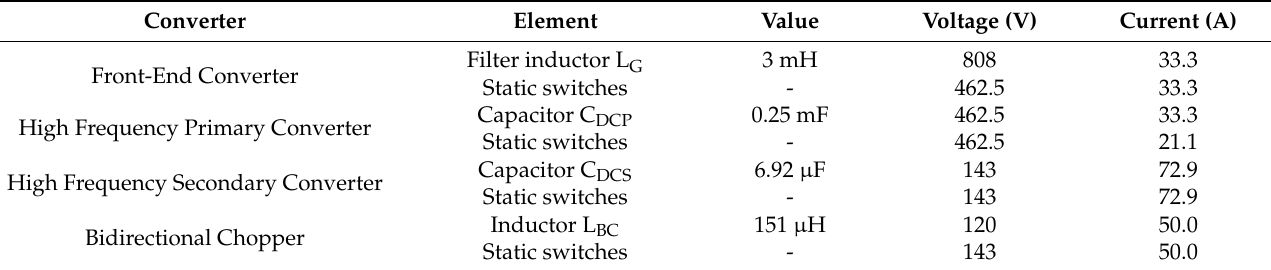
Table 5. Sizing values of the BWV2H power converters.